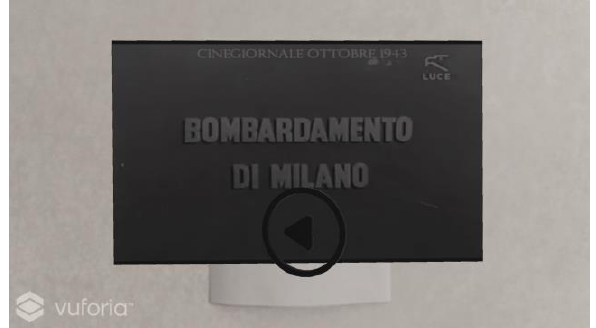
Figure 12. AR app created with